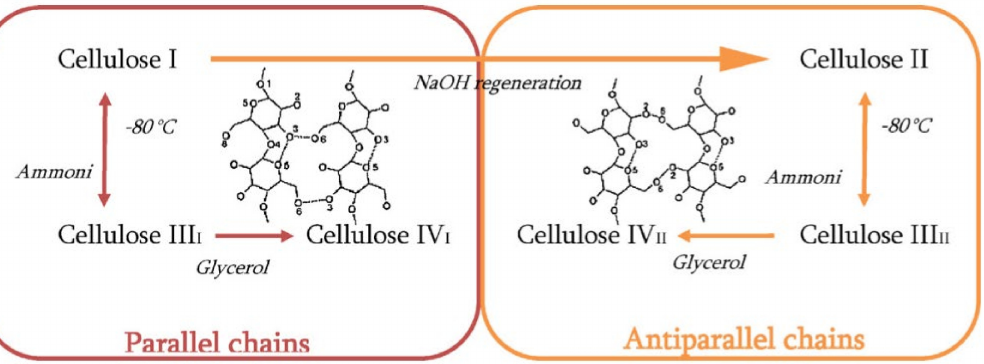
Figure 2. Methods to obtain different cellulose polymorphs. Reprinted/adapted with permission from Ref. [38]. License Number: